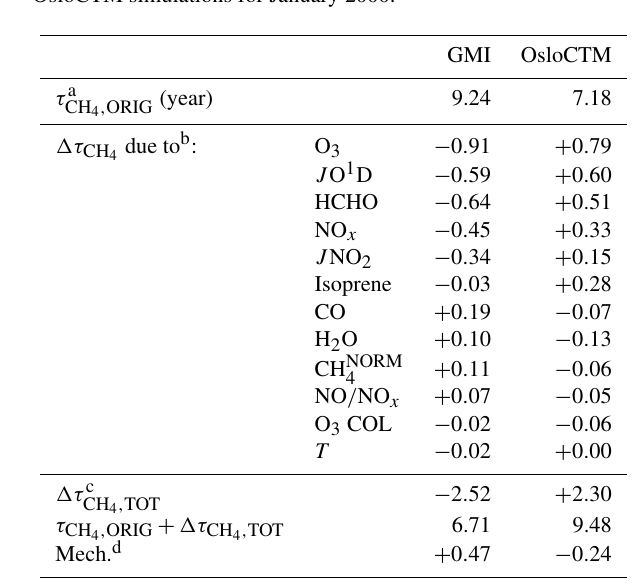
Table 1. Accounting of CH 4 lifetime differences between GMI and OsloCTM simulations for January